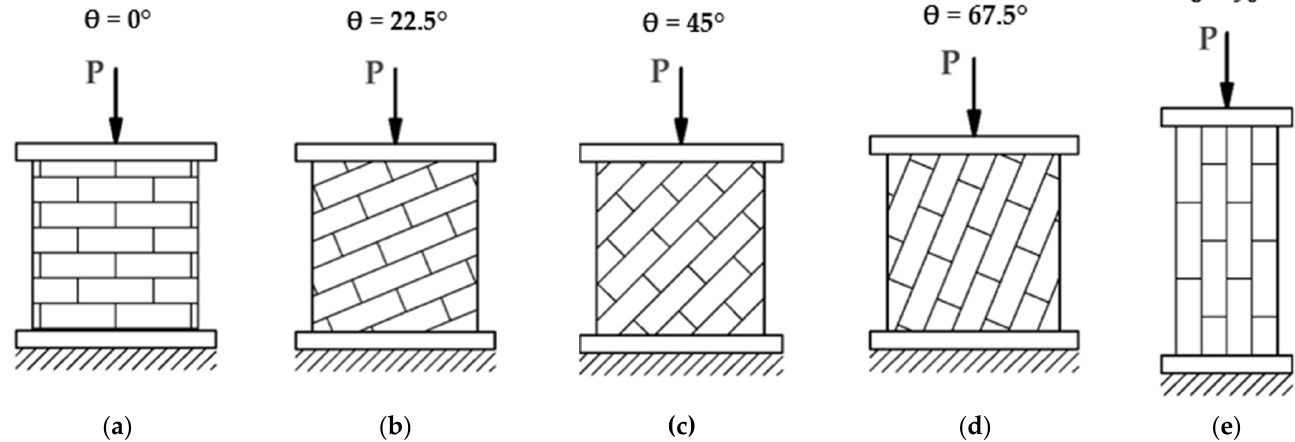
Figure 5. Load application diagram for compressed wall samples at different angles of bed joints ( a ) θ = 0°, ( b ) θ = 22.5°, ( c ) θ = 45°, ( d ) θ = 67.5°, ( e ) θ = 90°.